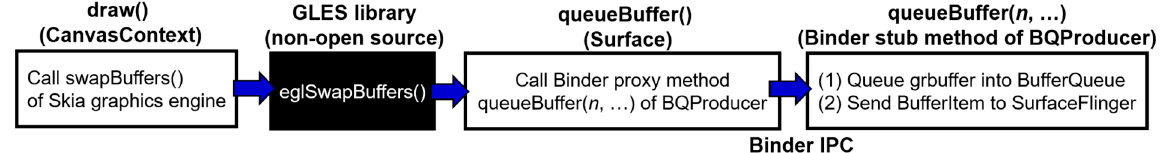
Figure 7. Process of requesting SurfaceFlinger to display an exFrame. These class and method names are the same across the various versions of the Android OS.